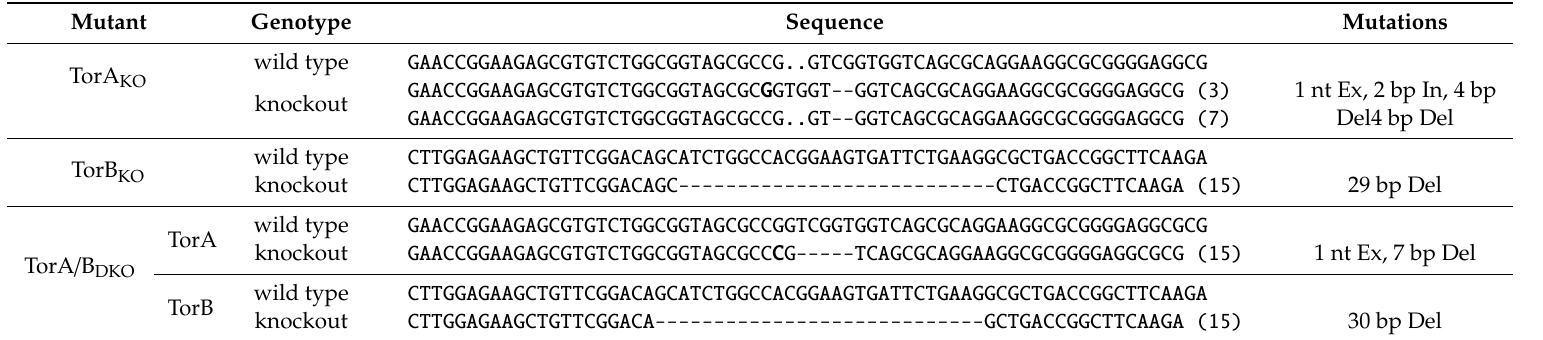
Table 3. Summary of mutations detected in the KO cell